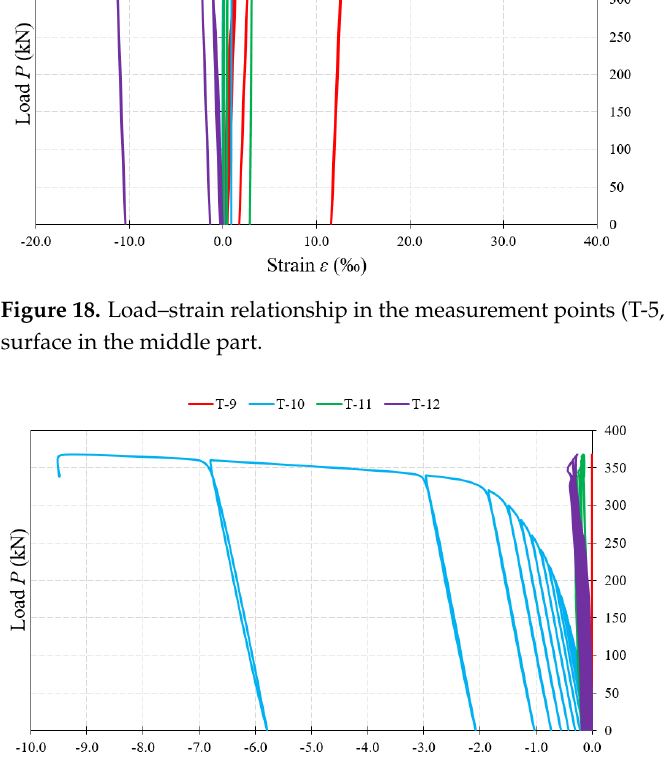
Figure 19. Load–strain relationship at the measurement points (T-10, T-11) located on the web surface at the external force.